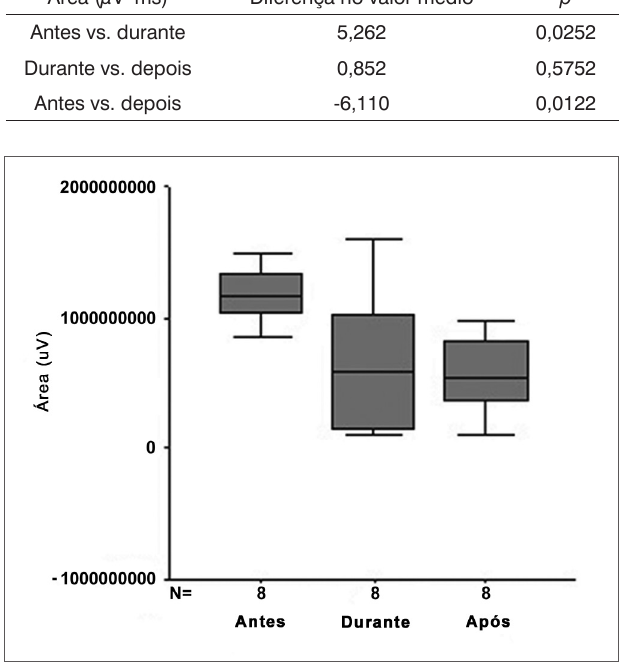
Figura 6. Gráfico box plot da área nos três momentos